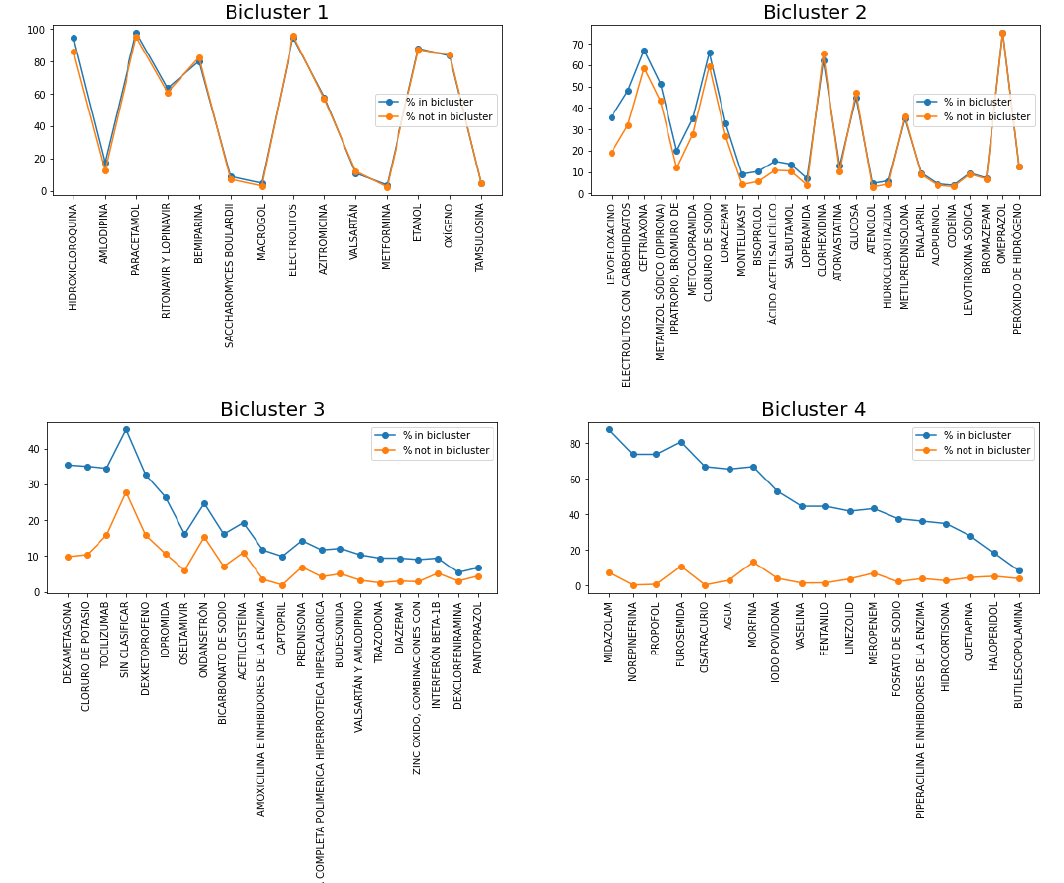
Figure14. Representativedrugsofeachbiclusterandtheirpercentageoftheiruseforpatientsbelonging Figure 14. Representative drugs of each bicluster and their percentage of use for patients belonging to to the bicluster versus percentage for patients not in the bicluster. the bicluster versus the percentage for patients not in the